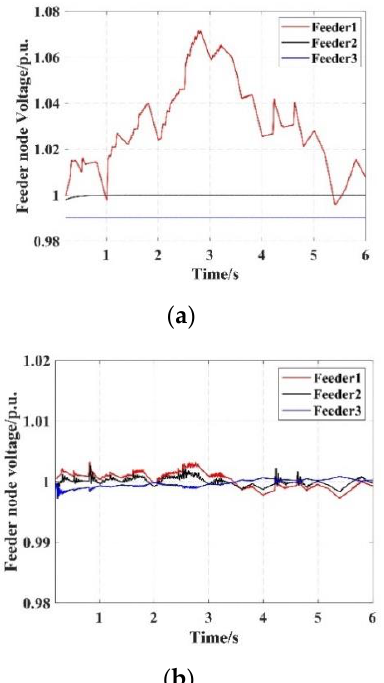
Figure 12. Feeder node voltage in mode 1: ( a ) SOP is uncommitted into operation; ( b ) Soft open point is committed into operation. Table 1. Standard deviation of feeder node